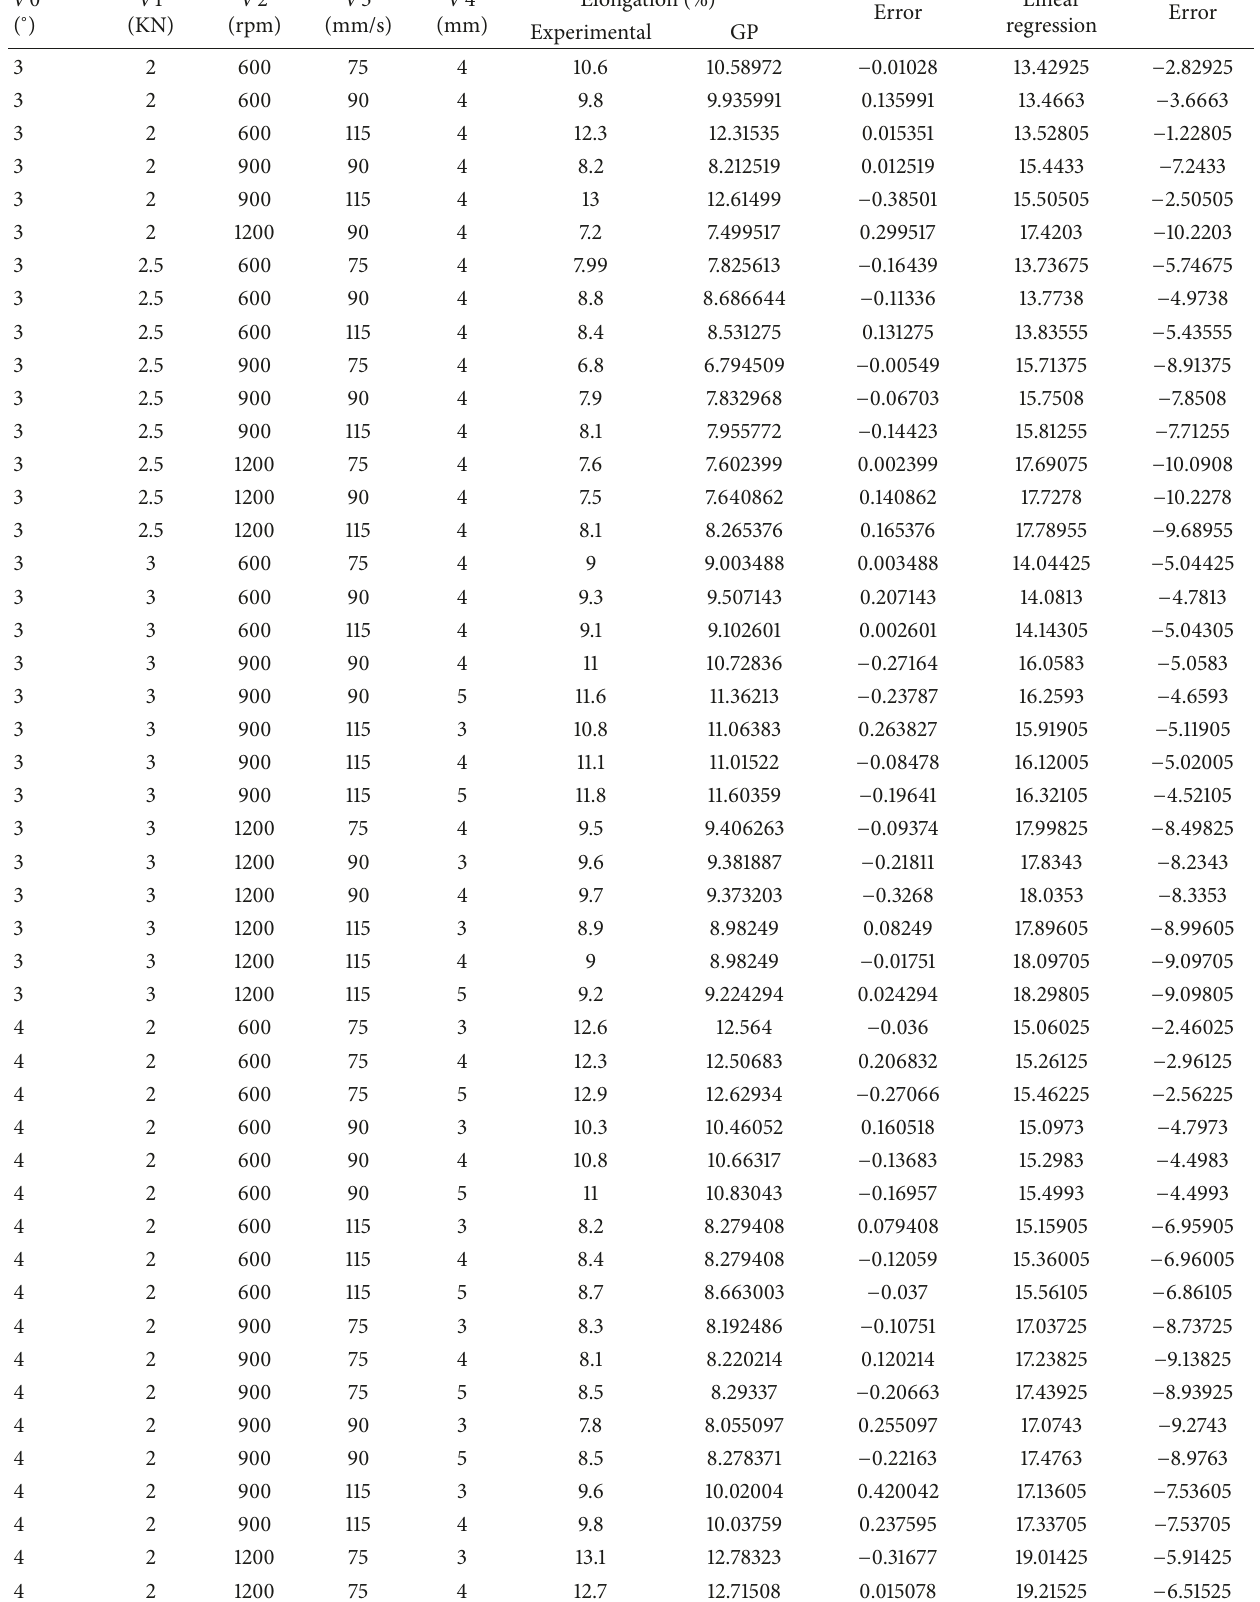
Table 5: Comparison between experimental and predicted values of % elongation at R 2 = 99.3